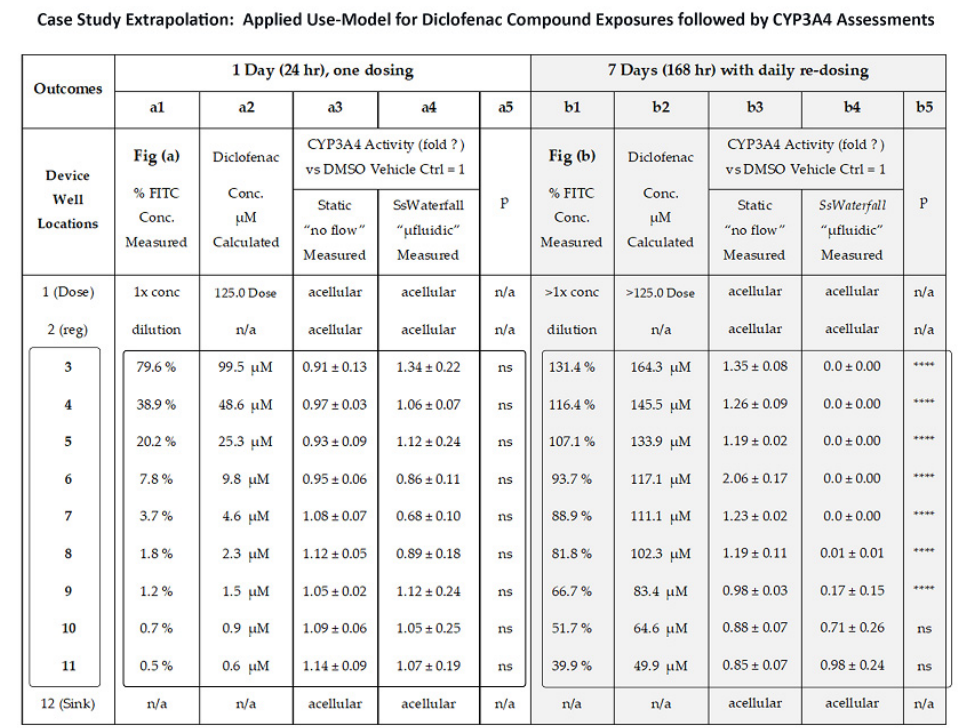
Figure 5. Percentage and quantification of FITC-flow and drug-concentrations in multiwell device. ( a ) FITC concentrations after 1 day, i.e., 24 h, and a single FITC bolus dose into well 1. ( b ) FITC concentrations after 7 days, i.e., 168 h, and daily FITC dosing into well 1. (TABLE: case study using drug diclofenac): Comparison of CYP3A4 activity after diclofenac treatment in HepaRG cells. ( a1 , b1 ) % concentrations of FITC surrogate, per well, measured. ( a2 , b2 ) µMolar concentrations of diclofenac, per well, calculated from FITC % (i.e., diclofenac dose (well 1) × FITC % (well specific). ( a3 , b3 ) CYP3A4 fold- Δ using device in “no flow” static mode. ( a4 , b4 ) CYP3A4 fold- Δ from compound dosing in device µfluidics. ( a5 , b5 ) Values are mean ± SEM, (n = 10) **** p < 0.00001.